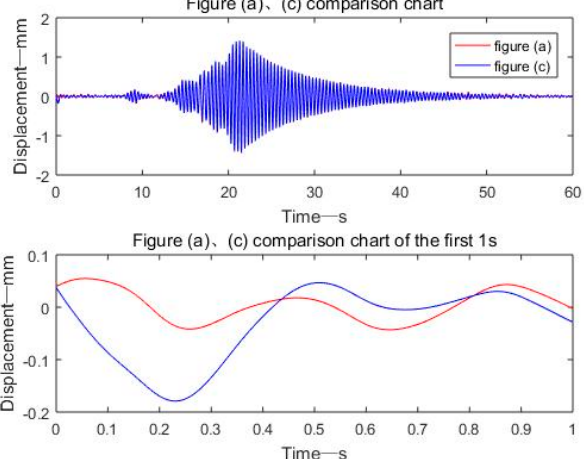
Figure 18. Four methods to realize dynamic displacement reconstruction of bridge: ( a ) Frequency domain bandpass filtering; ( b ) EMD adaptive filtering; ( c ) FFT+EMD filtering; ( d ) EEMD adaptive filtering.